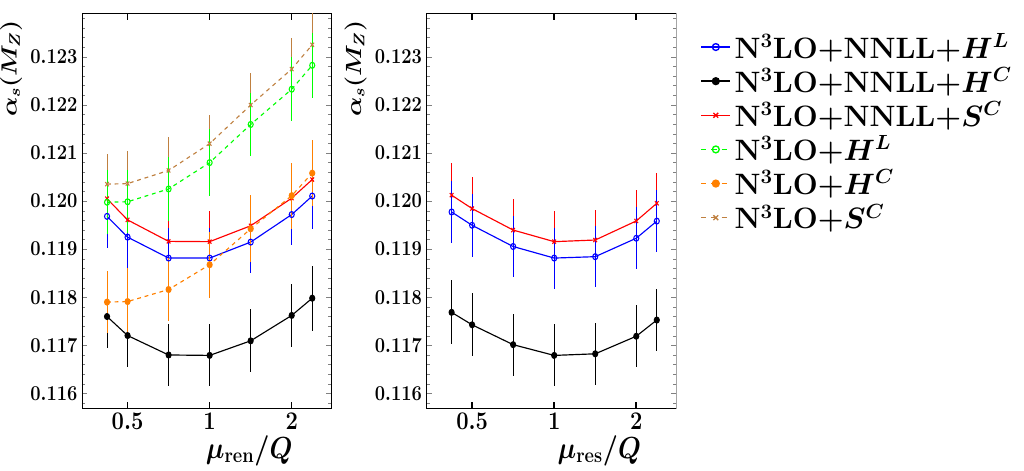
Figure 4 . Dependence of ( R 2 ) (cid:12)t results on the renormalization and resummation scales. The (cid:12)t range for S C , H C and H L setups is [ (cid:0) 2 : 25 + L ; (cid:0) 1] with L = log